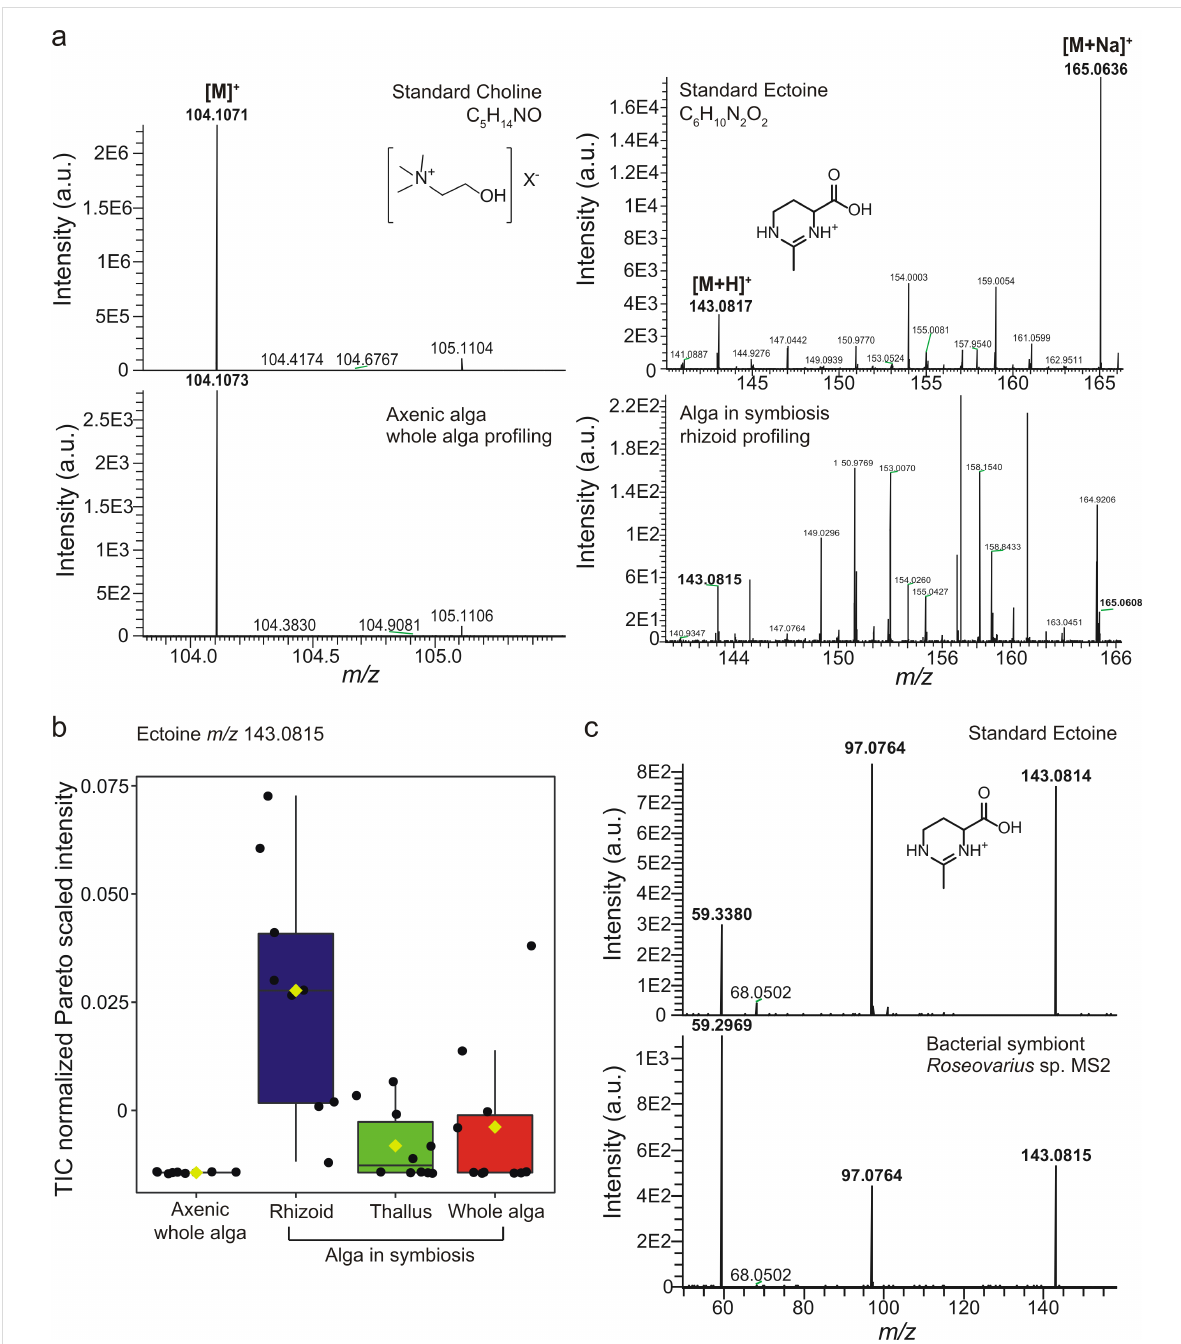
Figure 2: Identification of significant features associated with axenic or bacterial symbiont-associated alga Ulva mutabilis (phenotype slender). a) The structural determination was achieved by spectral matching with the analytical standards using AP-SMALDI-HRMS. b) Relative amounts of ectoine ( m / z 143.0815 for [M + H] + ) were determined by AP-SMALDI-HRMS measurements to compare different tissues: axenic and algae in symbiosis. One- way ANOVA with a Fisher HSD post hoc test found choline to be significant in profiles of axenic algae (F = 42, P -value < 0.0001) and ectoine in profiles of rhizoidal zones of algae in symbiosis (F = 4, P -value < 0.005) (colour code with reference to Figure 1a). c) Ectoine ( m / z 143.0815 for [M + H] + , precursor ion) was identified in a single colony of the bacterial symbiont Roseovarius sp. MS2 using AP-SMALDI-HRMS/MS analysis.